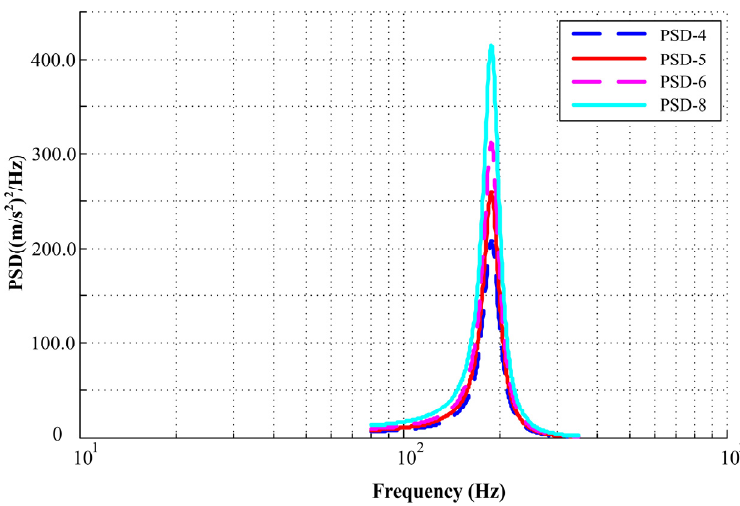
Figure 5. Random vibration response spectrum curve under different input acceleration PSDs. Table 2. Main parameter values.